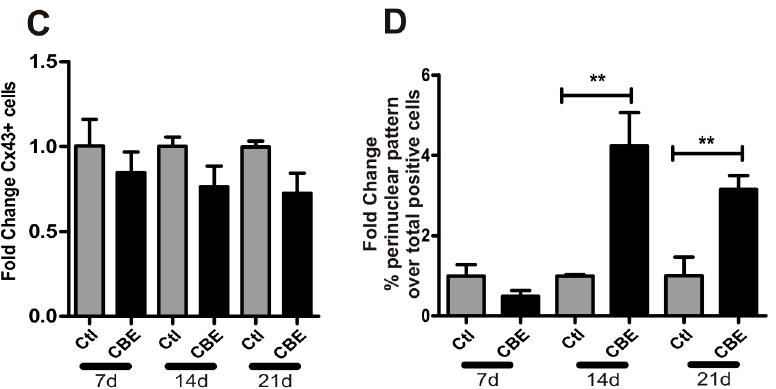
Figure 2. Connexin 43 expression and distribution are altered following CBE treatment. Relative expression of Cx43 and Integrin- β were assessed by qPCR in CBE-treated osteocytes at days (d) 7, 14 and 21 ( A ) Data were expressed as fold increase of gene expression (2 − ∆ C t ) in the cells treated with CBE versus untreated cells (FI).; Cx43 presence was revealed by immunofluorescence in osteocytes treated with CBE for 7, 14 and 21 days. A representative image of each condition is shown using two different augmentations ( B ); the fold change of Cx-43 positive cells relative to the number of total cells ( C ) and the fold change in the percentage of cells presenting a perinuclear pattern relative to the total number of positive cells ( D ) were evaluated. Data are expressed as mean ± SD ( n = 5) and are representative of three independent experiments performed. * p < 0.05, ** p < 0.01, *** p < 0.001, t -test.